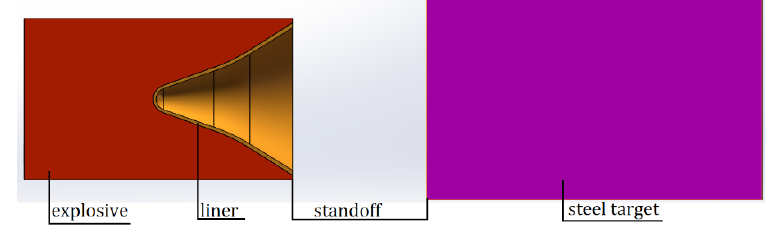
Figure 2. Penetration model of the standoff is 1 – 3 LD.